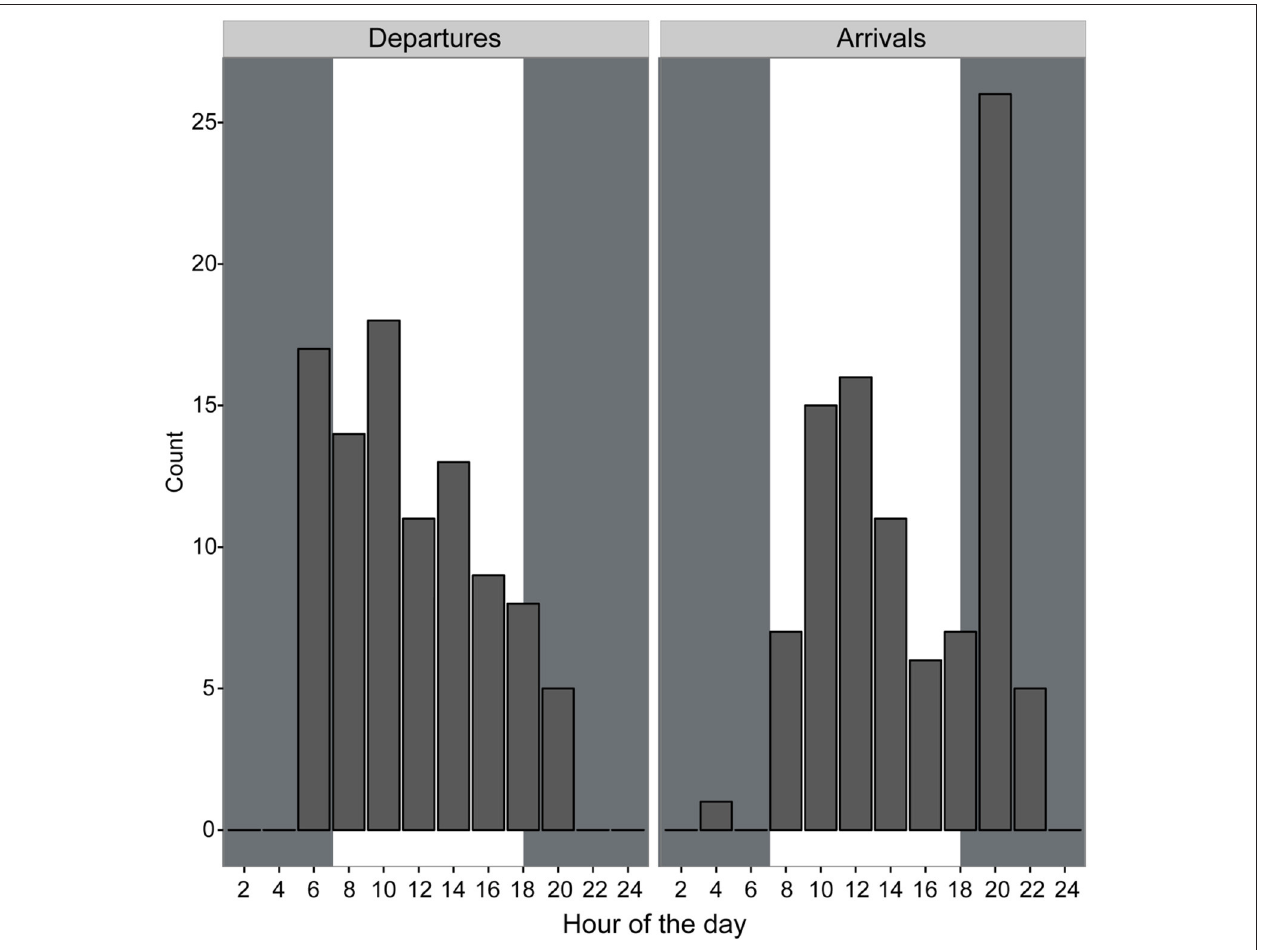
FIGURE 3 | Departures and arrivals of brown noddies from the nests determined using GPS tracking data binned into 2-h intervals. Gray shaded areas indicate night; white shaded areas indicate daytime.